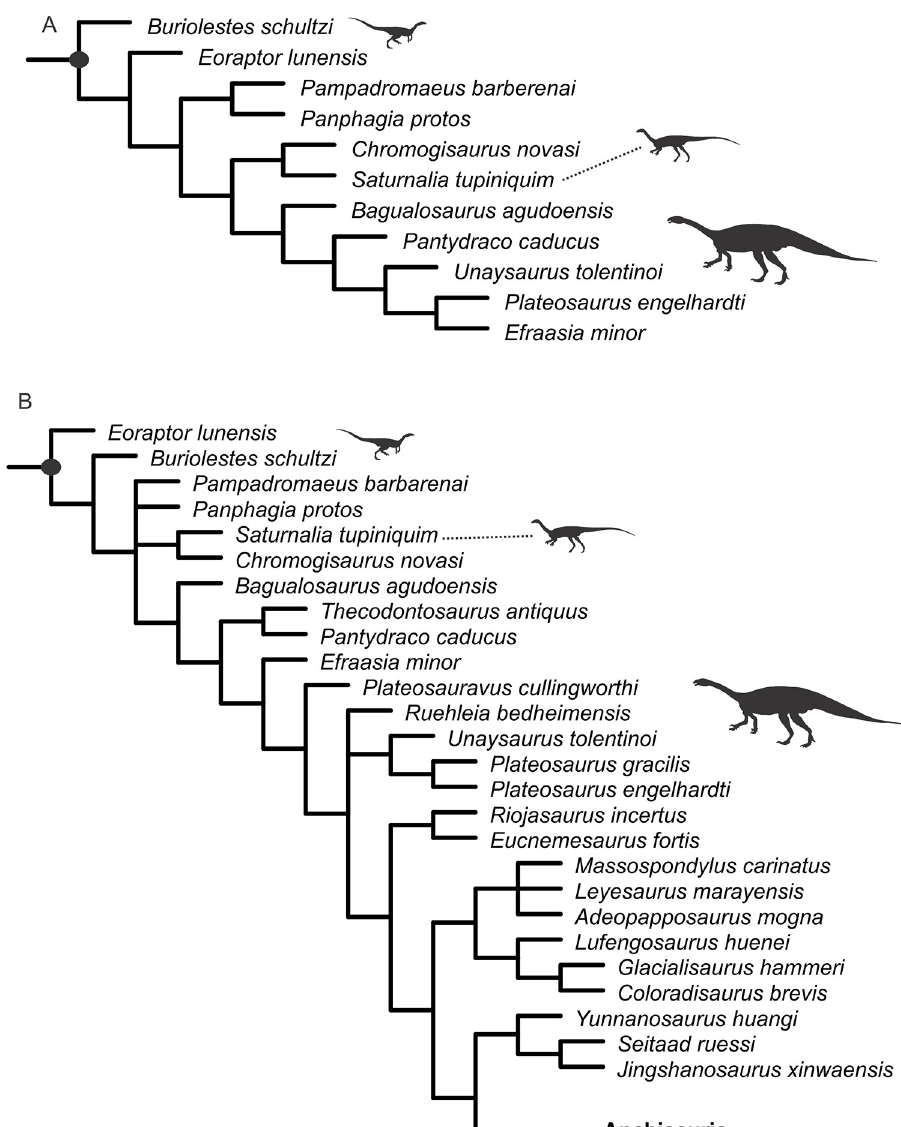
Fig 12. Results of phylogenetic analyses. A. Strict consensus trees of the 32 MPTs recovered in the phylogenetic analysis focusing on early dinosaur taxa. B. Strict consensus of the 150 MPTs recovered in the phylogenetic analysis focusing on non-neosauropodan